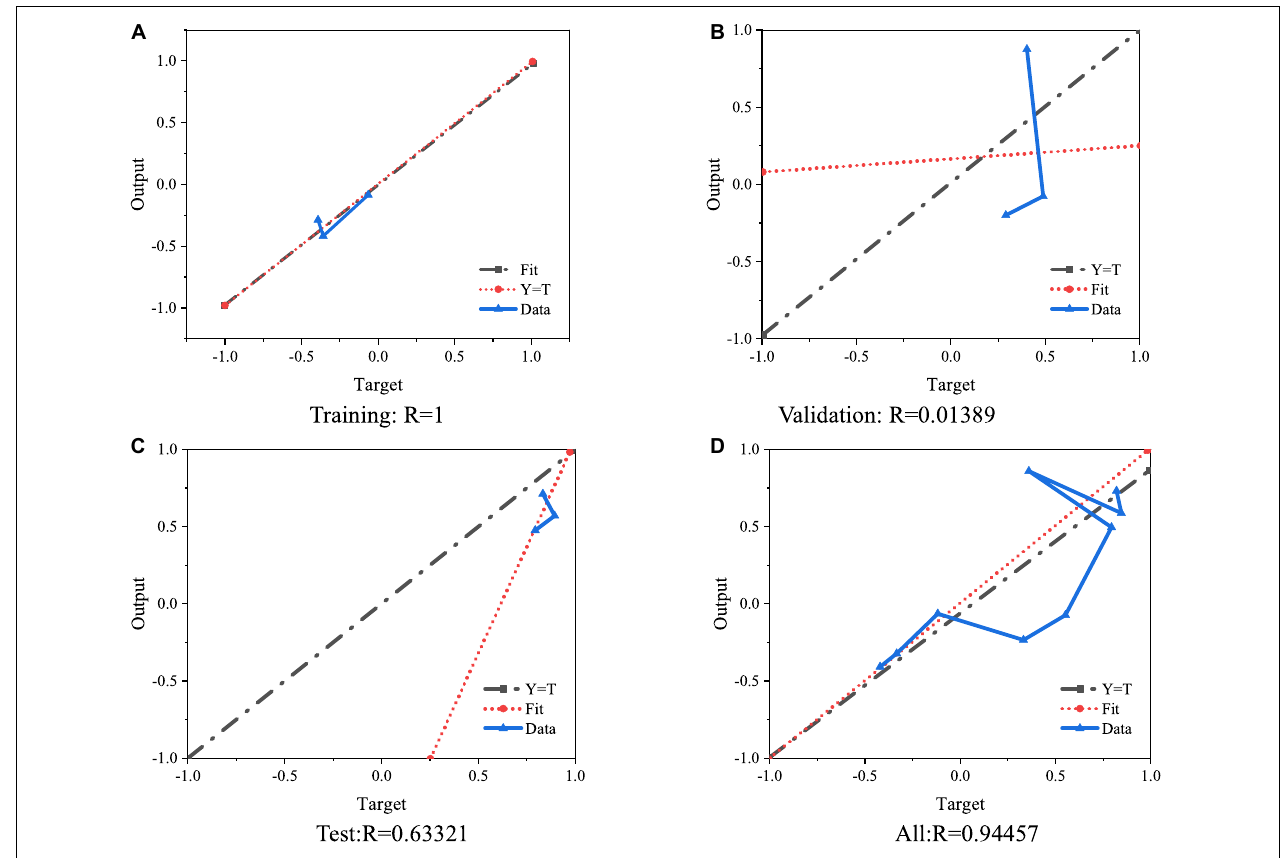
FIGURE 10 | Training error based on BPNN. (A) Training: R = 1. (B) Validation: R = 0.01389. (C) Test: R = 0.63321. (D) All: R =